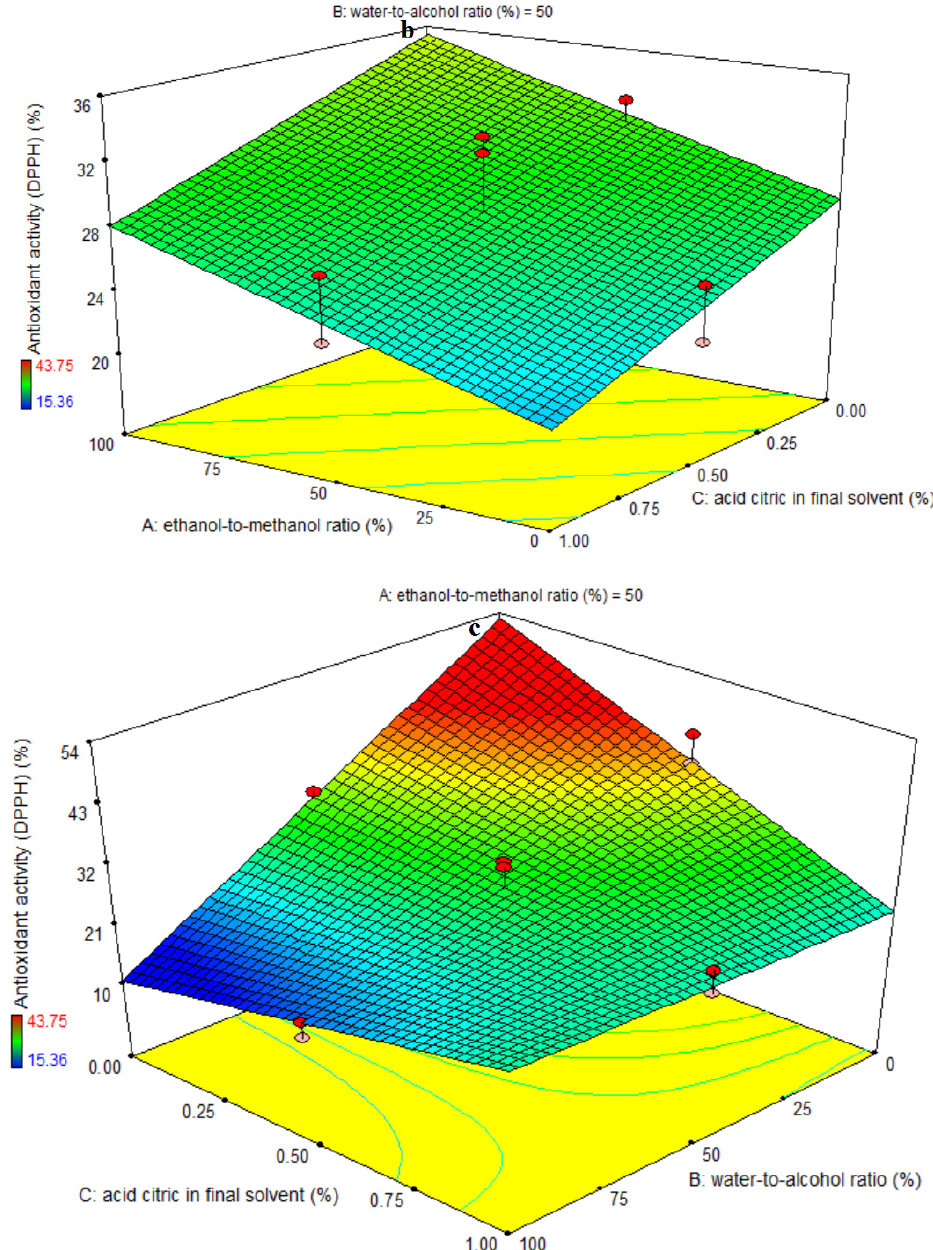
Figure 4. Effects of ethanol-to-methanol ratio (%), water-to-alcohol ratio (%) and citric acid in final solvent (%) on antioxidant activity in terms of DPPH radical scavenging activity (%) in eggplant peel extraction. ( a ): The interaction effect of factors A and B on the intermediate level of factor C., ( b ): The interaction effect of factors A and C on the intermediate level of factor B., and ( c ): The interaction effect of factors B and C on the intermediate level of factor A.